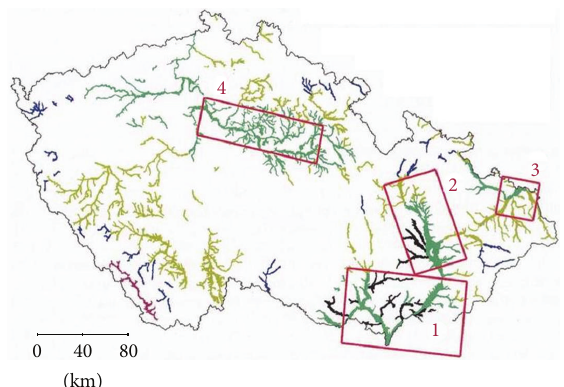
Figure 1: Distribution of floodplain forests in the Czech Republic